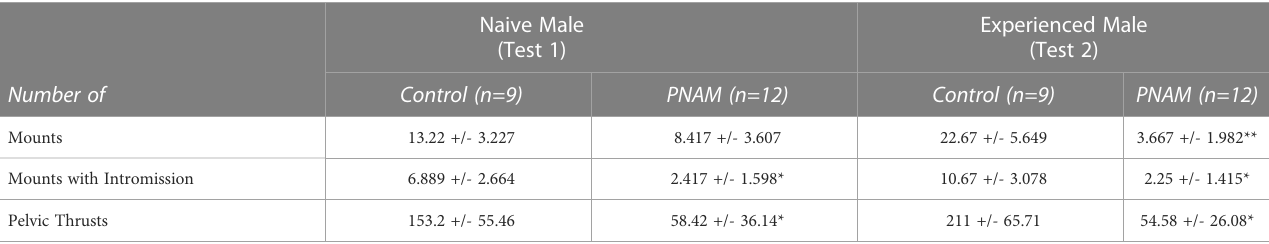
TABLE 2 Prenatal DHT exposure affect the number of different parameters of male copulatroy behvaiour in the adult male mice. PNAM, prenatally- androgenized male. Mean +/- SEM.